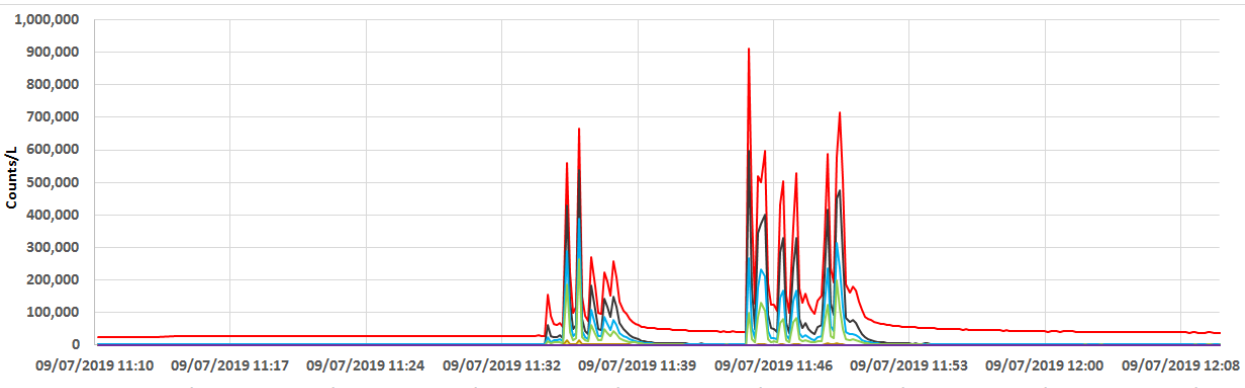
Figure 4. Real- time graph of ECSHA using “JustFog” ECs measured in counts/L, with a sampling Figure 4. Real-time graph of ECSHA using “JustFog” ECs measured in counts/L, with a sampling time of 10 s. time of 10 s.